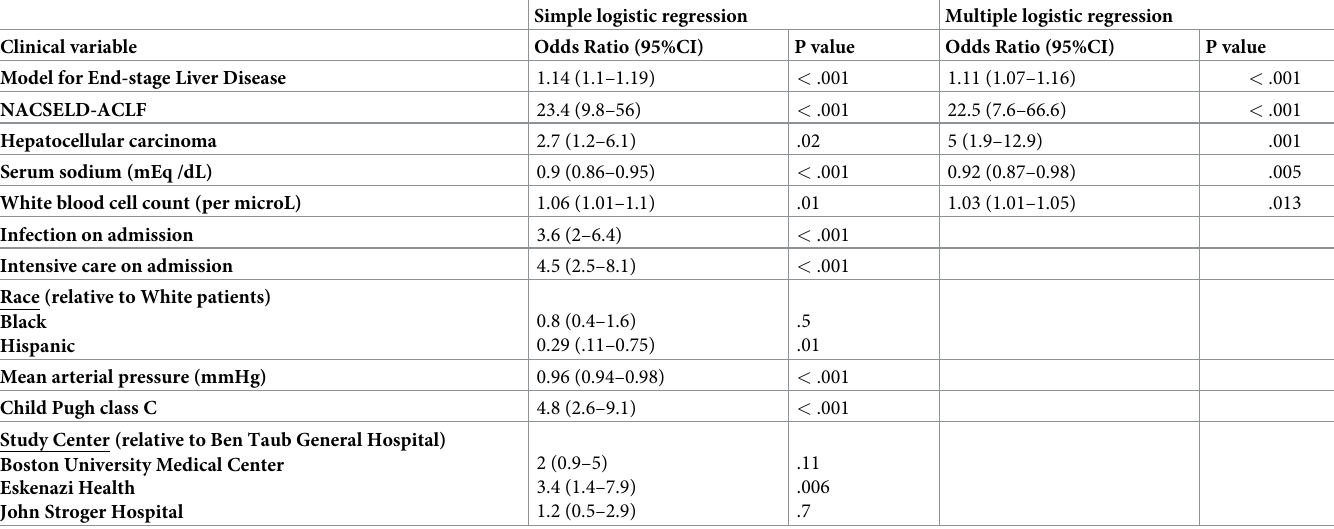
Table 4. The early predictors of hospital mortality on simple and multiple logistic regression.